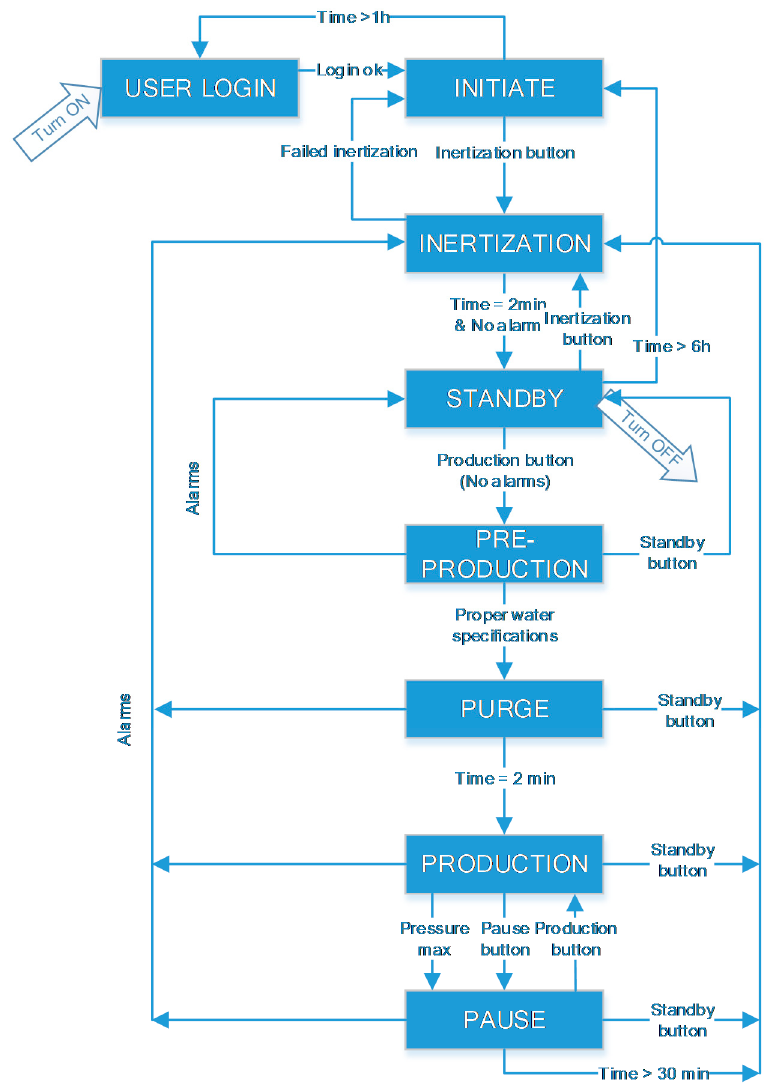
Figure 9. PEM electrolyzer control flow diagram: whole operating sequence.